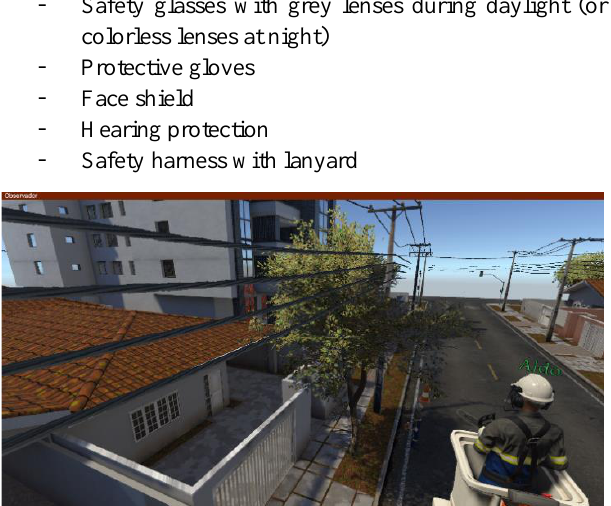
Figure 10. An electrician in the elevator bucket after a L-type prune, being watched by an instructor in observer mode.